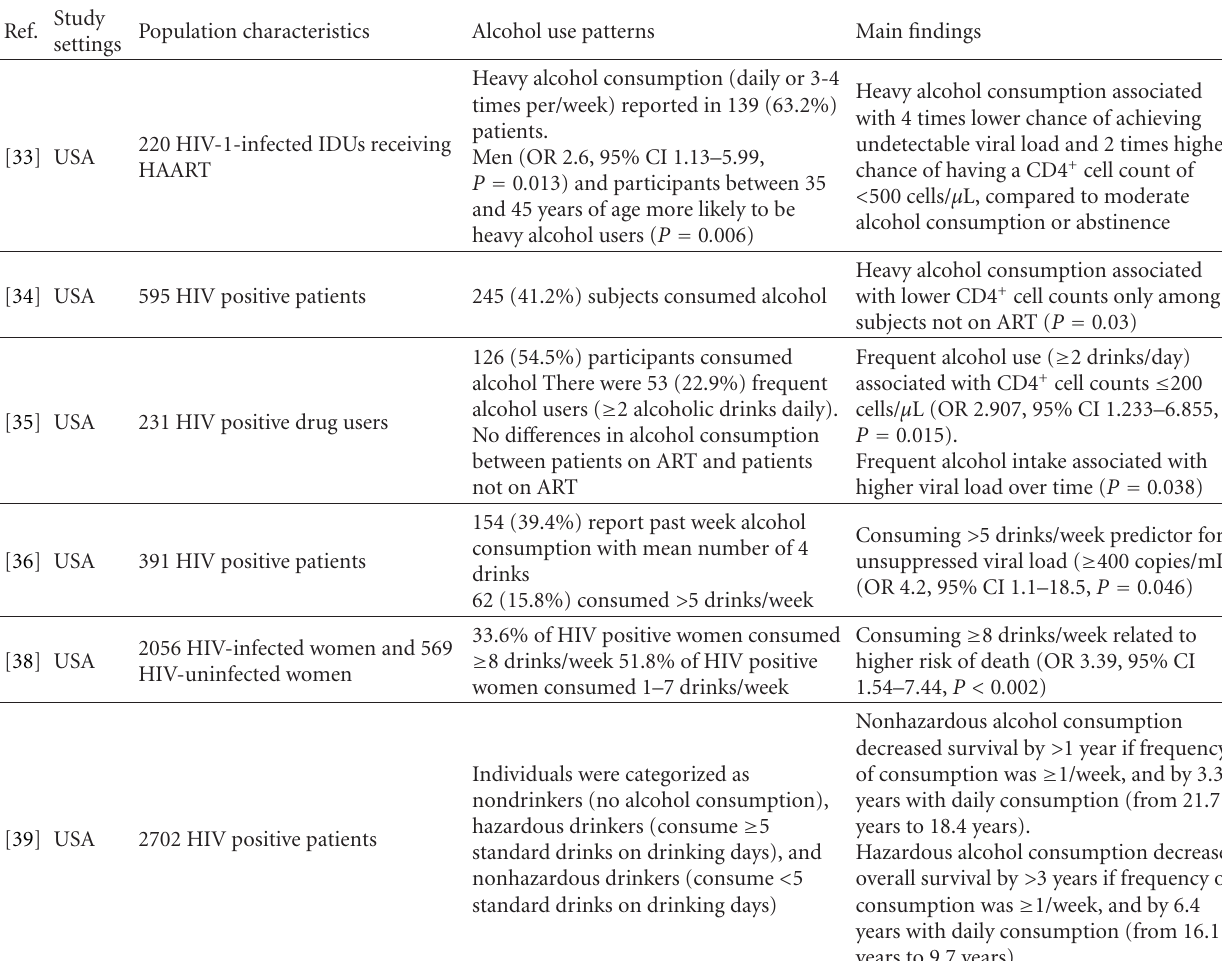
Table 2: The Role of Alcohol on the Immune System and the HIV Viral